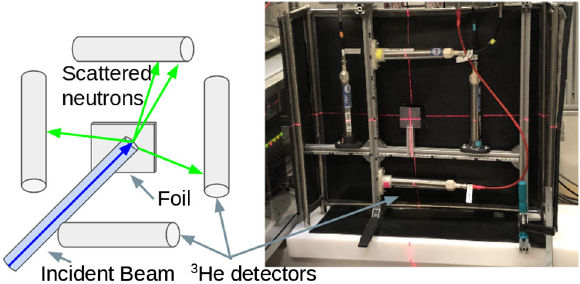
3. Isotropic quasiparasitic beam monitor concept. The thin foil is placed in the beam of neutrons (denoted by the blue line). Small percentage of the neutrons are scattered from the foil (denoted by the green line). Left: Conceptual cartoon. Right: Photo of the experimental setup for the measurements. The laser cross shows the center of the neutron beam